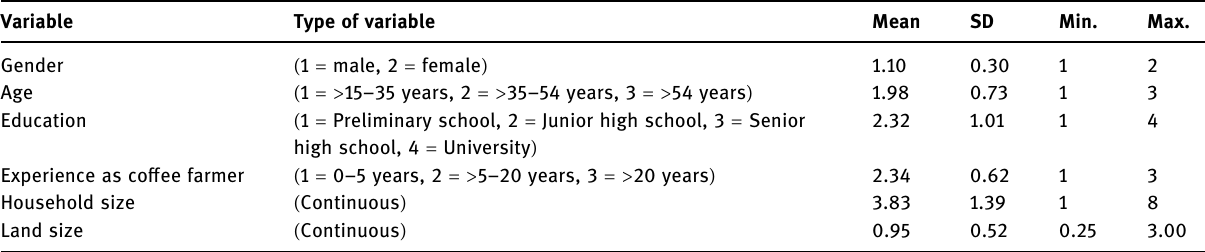
Table 1: Farmer characteristics ( n = 234 farmers )